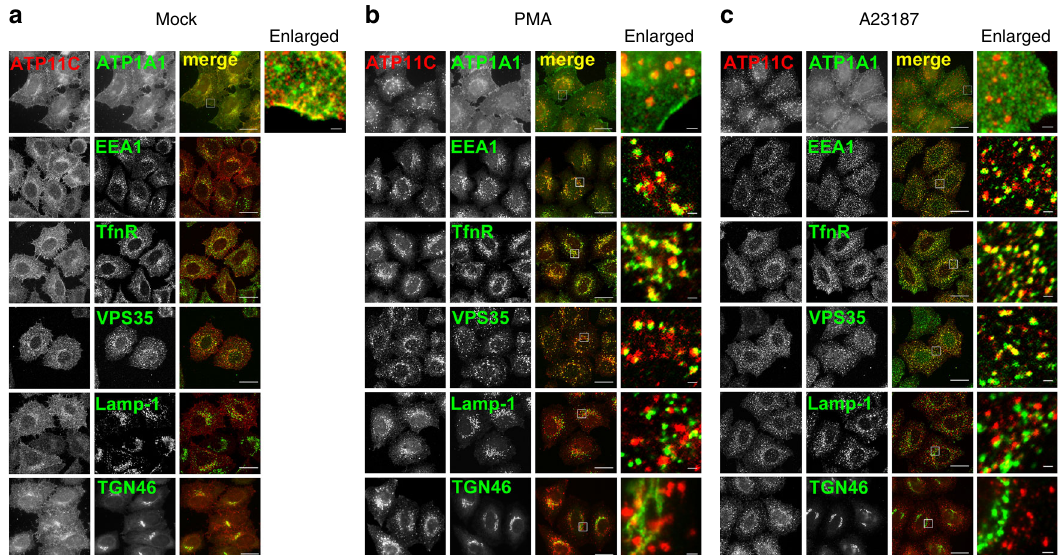
Fig. 2 Internalized ATP11C is localized to early/recycling endosomes. a – c HeLa cells stably expressing C-terminally HA-tagged ATP11C was treated for 15 min with vehicle alone ( a ), 400 nM PMA ( b ), or 1 μ M A23187 in the presence of 1.8 mM of CaCl 2 ( c ). The cells were fi xed and doubly stained for HA and organelle markers: ATP1A1 (for the plasma membrane); EEA1 (for early endosomes); transferrin receptor (TfnR); VPS35, a component of retromer complex (for early/recycling endosomes); Lamp-1 (for late endosomes/lysosomes); and TGN46 (for trans -Golgi network). The cells were then incubated with Cy3-conjugated anti-rat and Alexa Fluor 488-conjugated anti-mouse, anti-rabbit, or anti-goat secondary antibodies. Images (except top and bottom panels) were obtained by confocal microscopy. Scale bars, 20 μ m. Insets are enlarged (bars, 1 μ